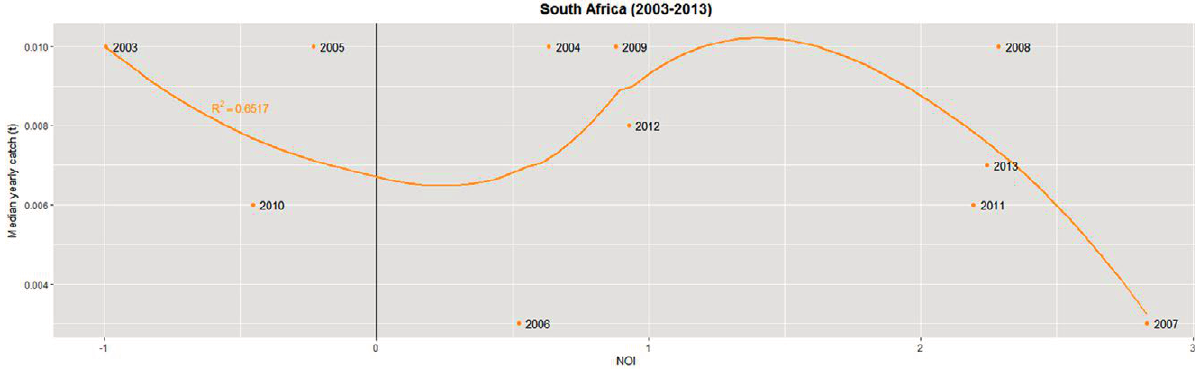
Fig. 12. – Median yearly skipjack catch in South Africa as a function of NOI signal, adjusted with a non-linear parametrized curve (rs=–0.799*, p-value=3.244e–7).